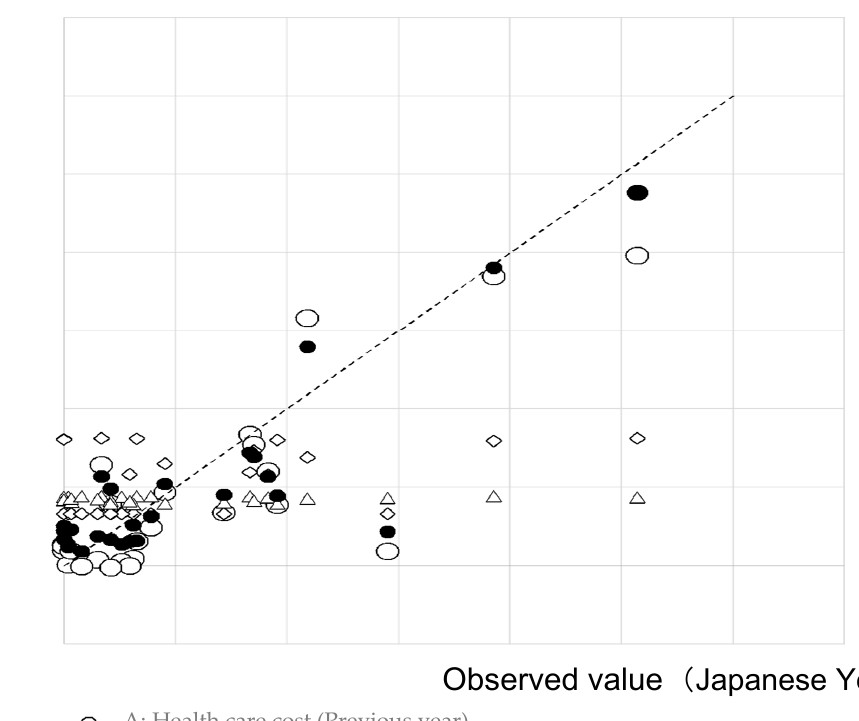
Figure 3. Plot of the predictive values of health care costs against the observed values.